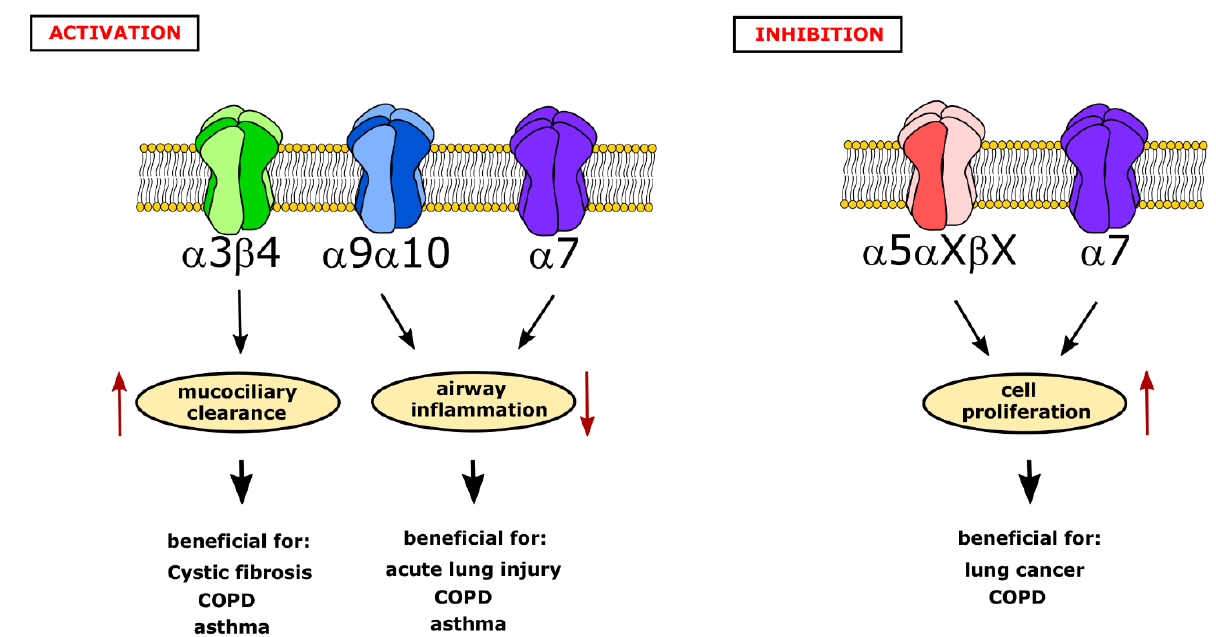
Figure 2. Possible strategies to pharmaceutically target nicotinic acetylcholine receptors (nAChR) in airway diseases. Activation of nAChR has two main beneficial effects: an increase in mucociliary clearance via α 3 β 4 receptors in the epithelium and a decrease of airway inflammation via α 9 α 10 and α 7 nAChR present in immune cells. These effects can be useful to attenuate symptoms of various airway diseases, such as cystic fibrosis, chronic obstructive pulmonary disease (COPD), asthma, and acute lung injury. In contrast, the inhibition of α 5 nAChR and α 7 nAChR could reduce the excess proliferation of airway smooth muscle or cancer cells and therefore could be a suitable therapeutic target for lung cancer or COPD.